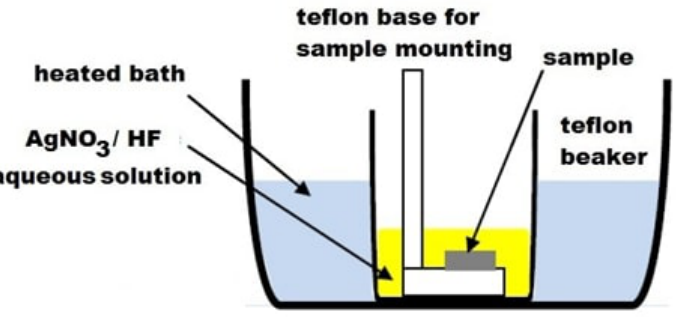
Figure 1. Schematic of the setup used for sample fabrication using the single-step MACE